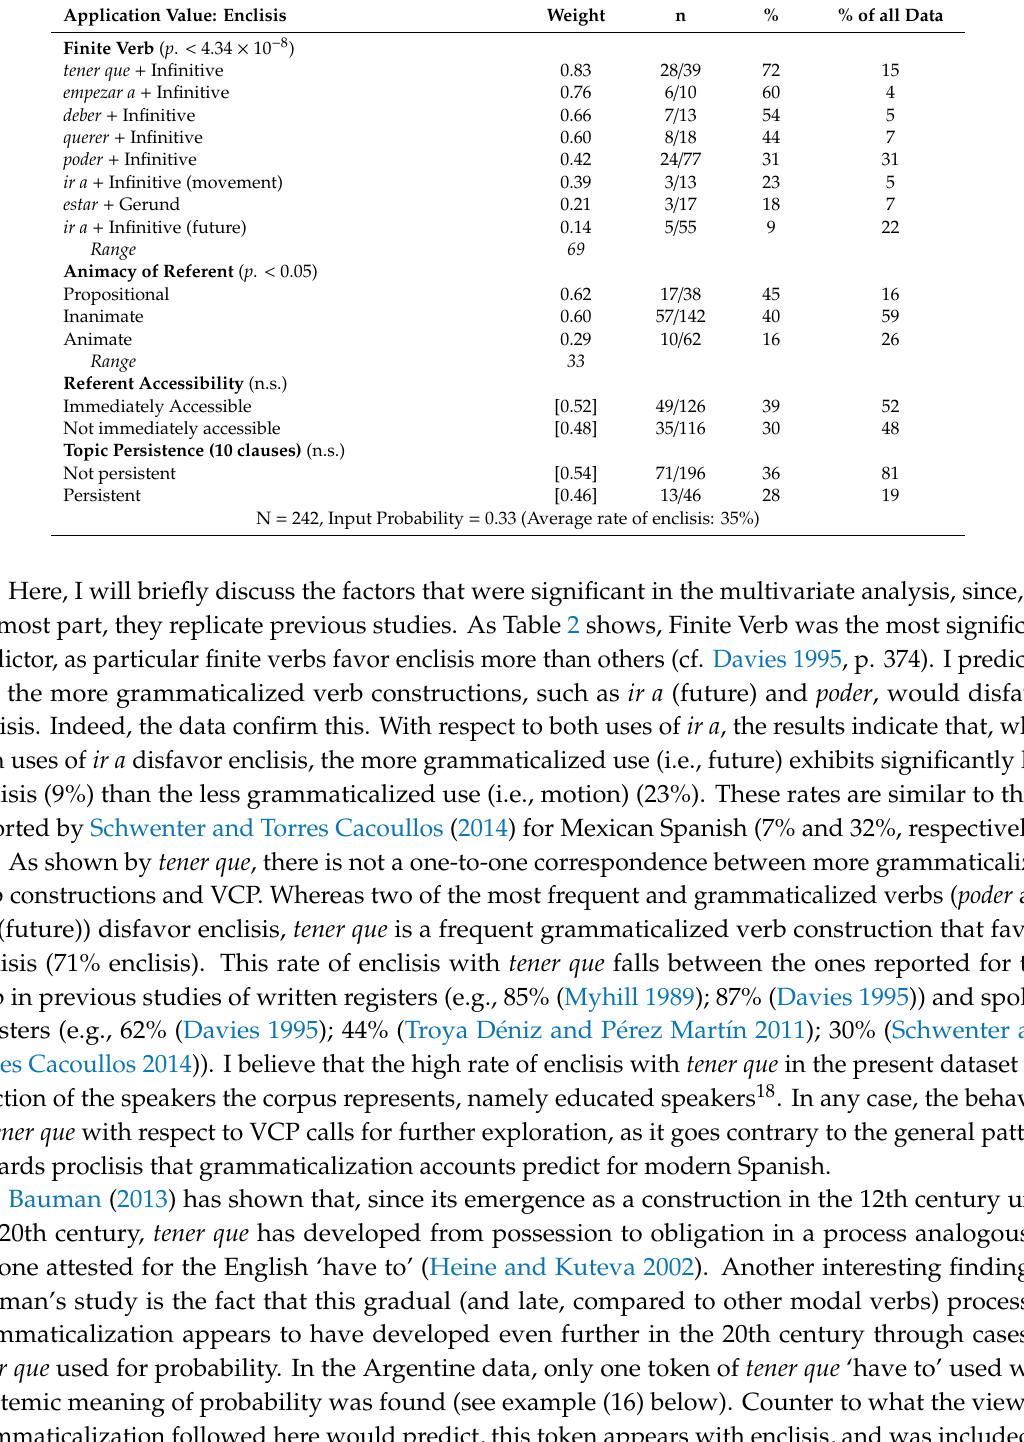
Table 2. Variable rule analysis: Factors contributing to speakers’ choice of enclitic position. Note: Factors with data in square brackets were not selected as